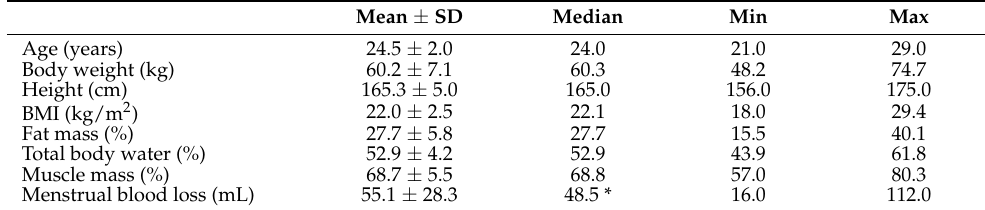
Table 1. The baseline characteristics of the participants of the study ( n =